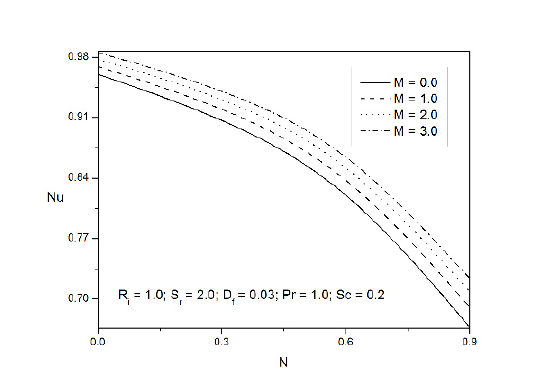
Figure 7. Effect of mixed convection parameter R Rate